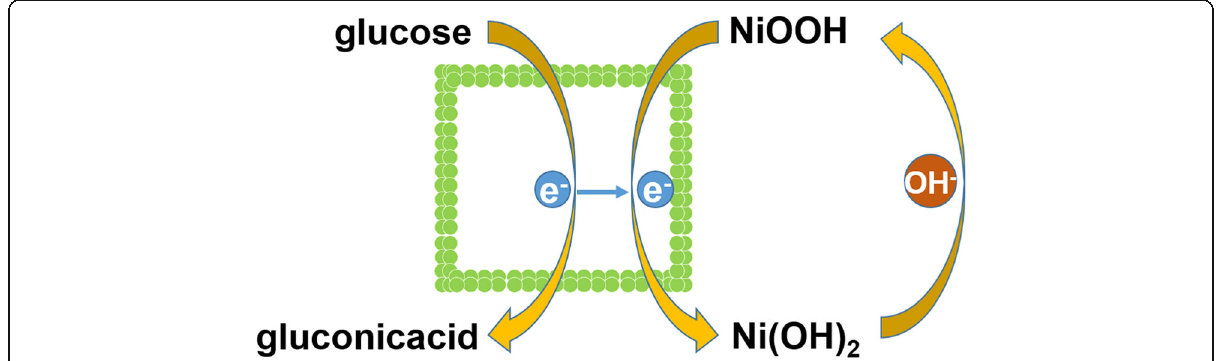
Scheme 1 The schematic diagram of electrocatalytic